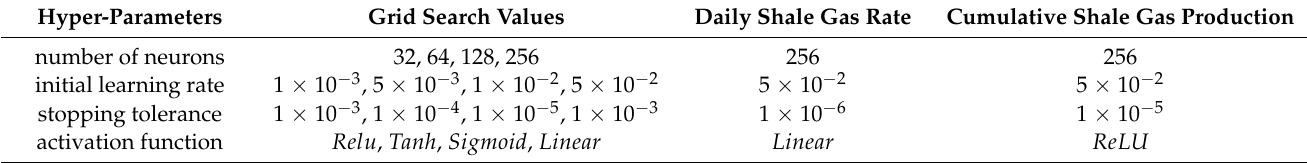
Table 2. The optimal grid values of hyper-parameters when using 100 training samples to train the ML models.